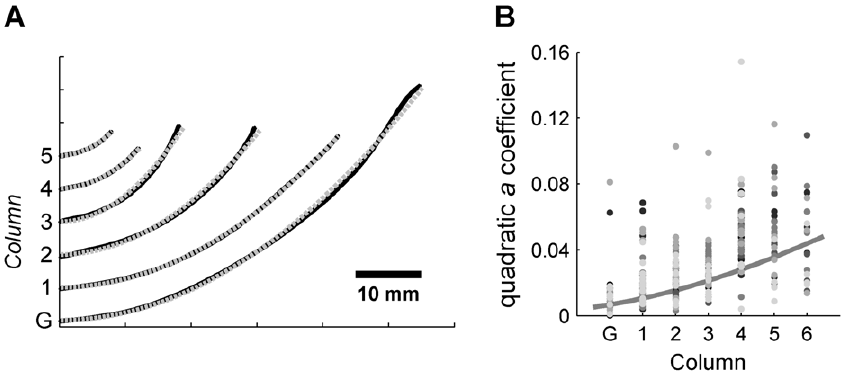
Figure 6. Quadratic approximation to the whisker 2D shape. ( A ) Examples of quadratic fits to the right C row whiskers from one rat. The scanned whisker data is shown in black. Each whisker has been offset vertically to reflect the whisker’s column. The best parabolic fit to each whisker is shown as a dotted gray line. ( B ) Quadratic coefficient a versus whisker column in the array for all 2D whisker data. Marker color indicates rat of origin and indicates that no significant differences were found across rats.